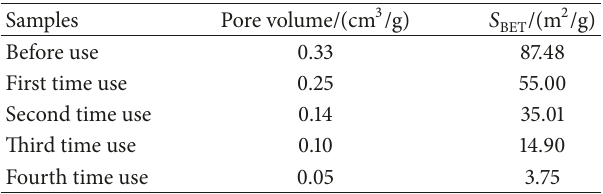
Table 3: The data of pore structure for P-CSHs-PEG2000 samples after different use